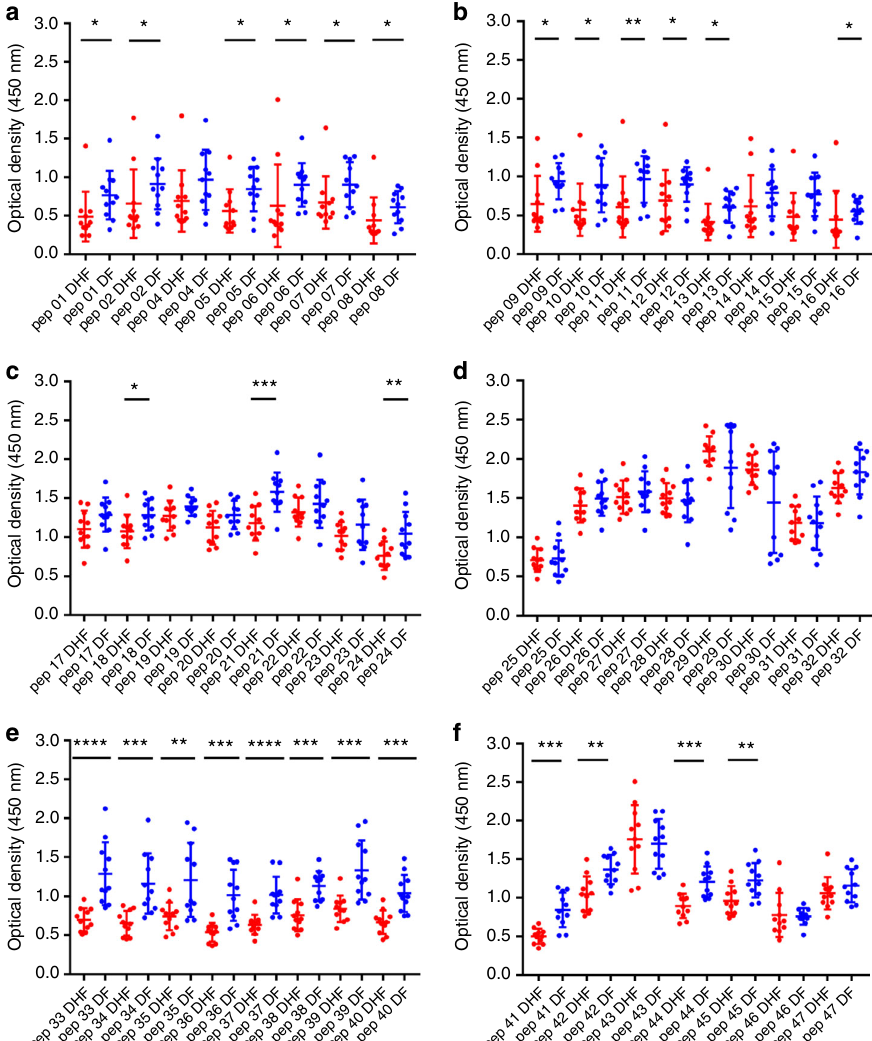
Fig. 6 DENV2 NS1 antibody responses to NS1 peptides in the critical phase. a – f DENV2 NS1-speci fi c IgG antibody responses to 47 DENV2 NS1 overlapping peptides were measured by ELISA in patients with DF ( n = 10) and DHF ( n = 10) on day 3 of illness. Differences in mean values between antibody responses to overlapping peptides in patients with DF and DHF were compared using the Mann – Whitney U test (two tailed). Error bars indicate the means and standard deviation (SD). * P < 0.05, ** P < 0.01, *** P < 0.001, **** P <